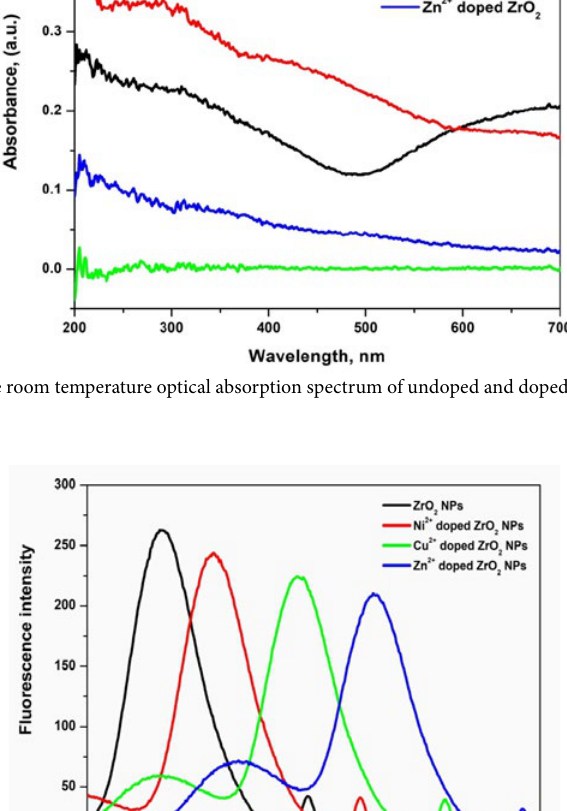
Fig. 2. The room temperature PL spectrum of undoped and doped ZrO Fig. 2 The room temperature PL spectrum of undoped and doped ZrO 2 NPs.